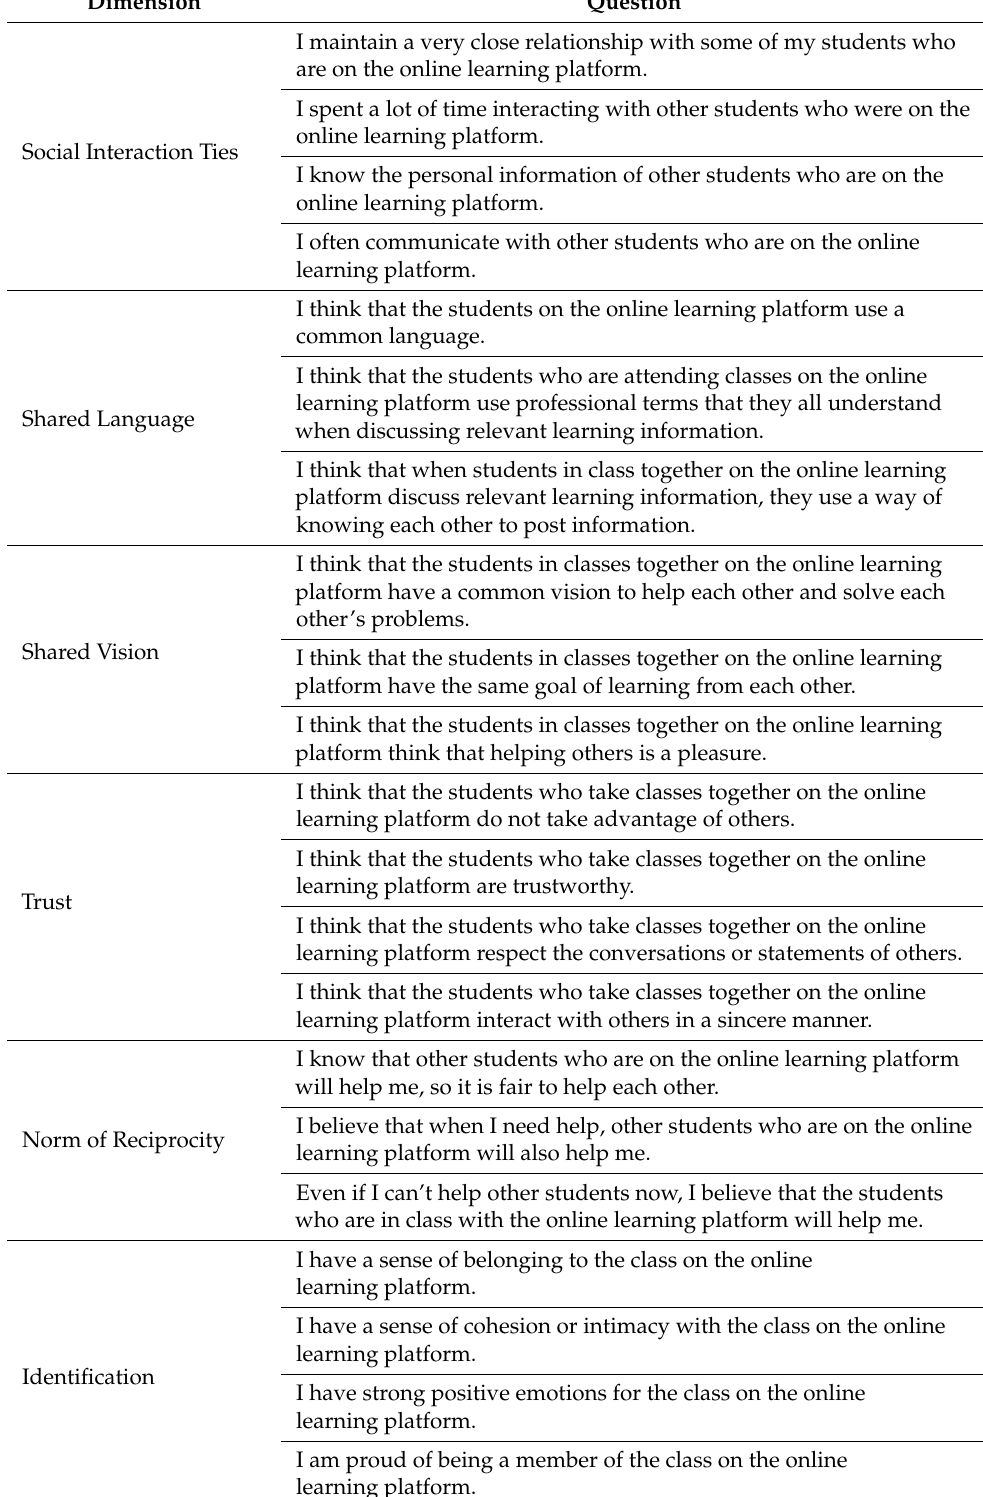
Table 2. Questionnaire items referenced from Chiu et al.